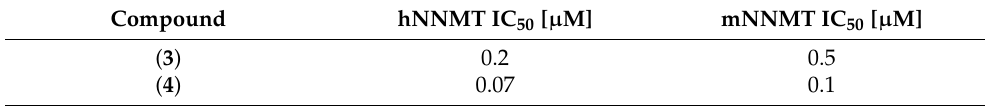
Table 5. hNNMT and mNNMT enzymatic activity of inhibitors ( 3 ) and ( 4